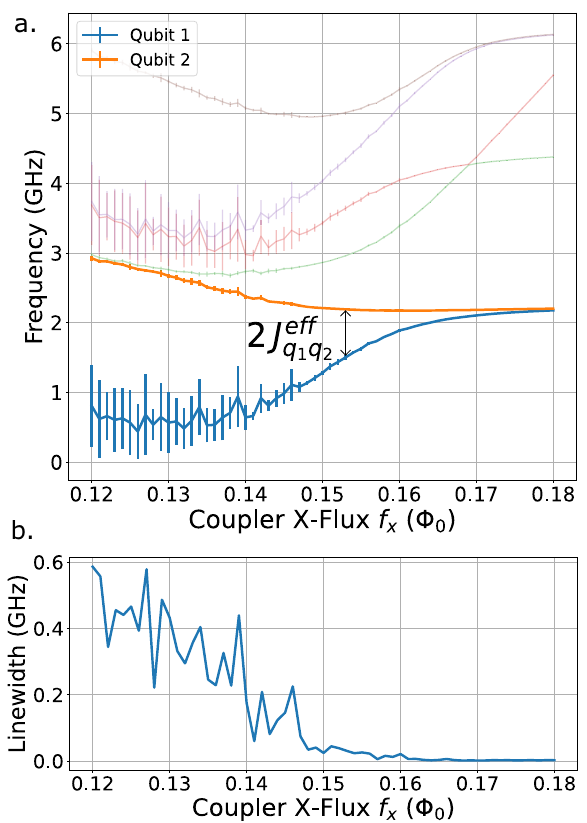
Fig. 5 Effects of Noise. a Full device simulation illustrating the effects of low frequency fl ux noise on the qubit-like energy levels. Displayed are the means and standard deviations of the full device energy levels compiling ten separate calculations with the described random fl ux operating point offsets. The two lowest energy levels are identi fi ed as the two initially degenerate qubit levels, þ(cid:3)j i and (cid:3)þj i . In the limit of no coupling, or large coupler f x , they reproduce single qubit behavior. As the coupler f x is lowered and cross chain coupling becomes signi fi cant, the previously degenerate qubit levels, shown in bold, split in the presence of cross chain coupling. Also shown, in lightly faded color, are the few next higher energy levels of the full device consisting of a mixture of coupler and higher qubit levels. Note that the coupler chain and the qubit levels have become comparable in frequency by coupler f x ≲ 0.15 Φ 0 . In this region, what were initially qubit-like energy levels, are now dressed by the coupler levels and the splitting of these two energy states no longer represents the effective qubit-qubit interaction strength ? . b Shown is the linewidth of the lower qubit-like level, calculated as the standard deviation of the transition frequency over multiple simulation runs in the presence of realistic fl ux noise. There is a region, f x = 0.15 − 0.18 Φ 0 , where signi fi cant cross chain coupling is present but where the effects of fl ux noise do not signi fi cantly broaden the lower qubit-like level's linewidth. For f x < 0.15 Φ 0 , the calculated linewidth suggests the coherence times of the qubit have deteriorated to the nanosecond